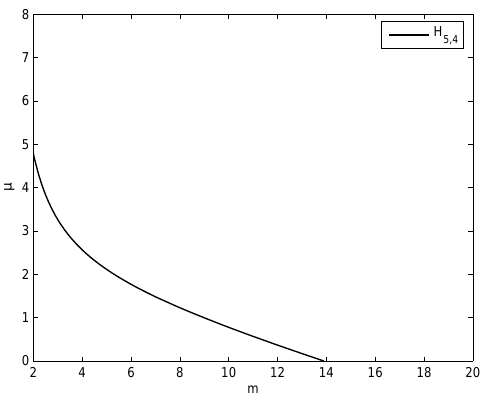
Figure 1. The boundary function H 5,4 in ( m , µ ) −